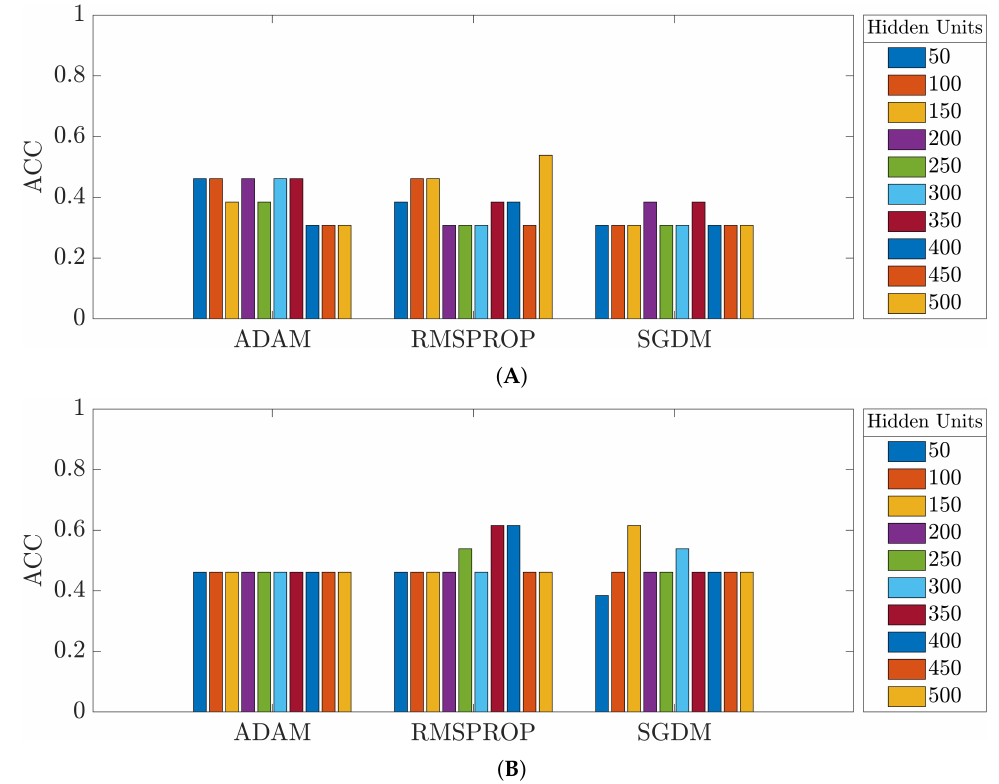
Figure 10. Accuracy of the networks trained with the original 35-mer adenosine dataset: ( A ) ULSTM network; ( B ) BLSTM